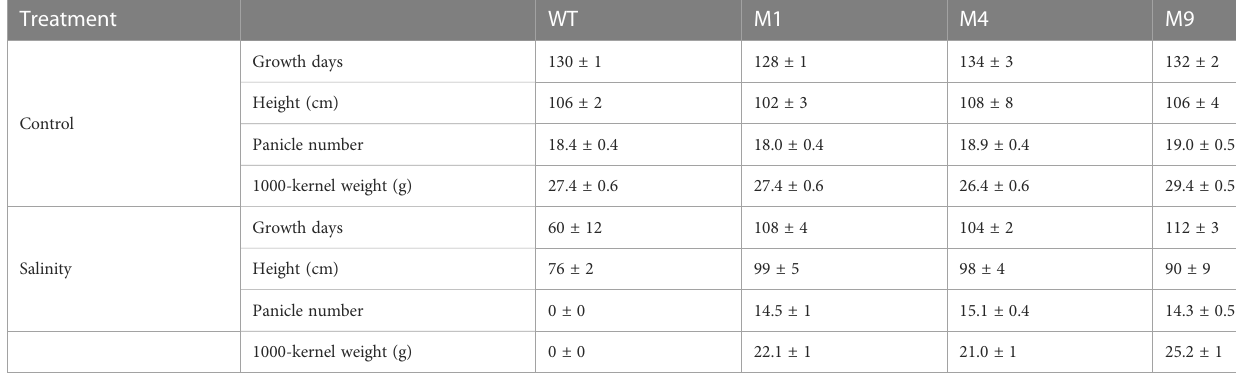
TABLE 3 Growth characteristics of 3-month-old wild-type (WT) and transgenic AtMSRB5 (M1, 4, 9) rice plants. Treatment